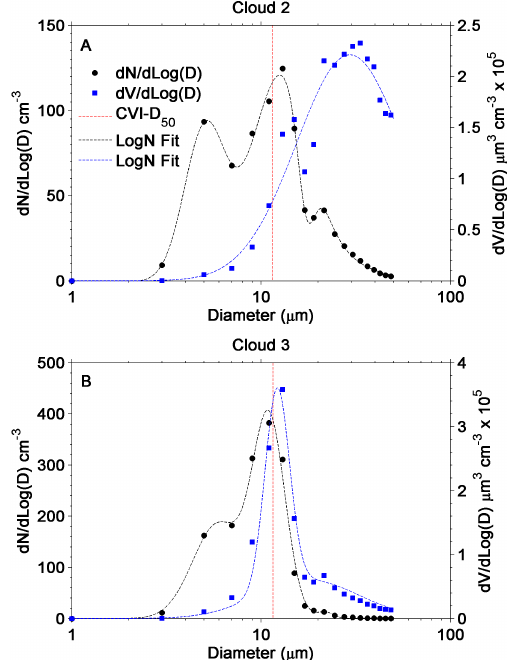
Figure 4. Average cloud droplet number size distributions for Cloud 2 (a) and Cloud 3 (b) measured by the FM-100 (black circles) and fit with a lognormal distribution function (black dashed lines). The average cloud droplet volume distributions (blue squares) and lognormal fits (blue dashed lines) are also shown for each cloud event. The CVI- D 50 is indicated on each panel by a red dashed